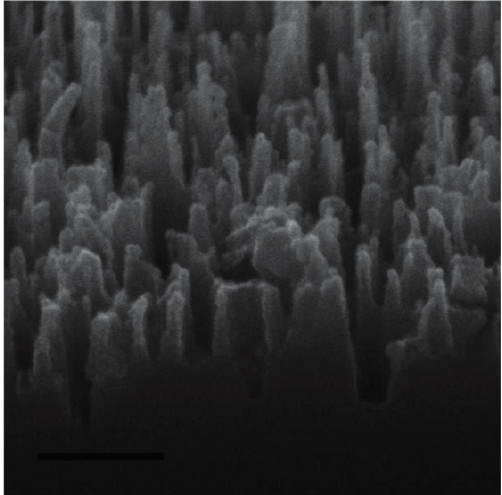
Figure 2. Scanning electron microscope (SEM) image of RIE textured silicon surface using plasma consisting of Cl 2 , CF 4 and O 2 gases (scale bar = 200 nm). Reprinted with permission from Elsevier, 2001